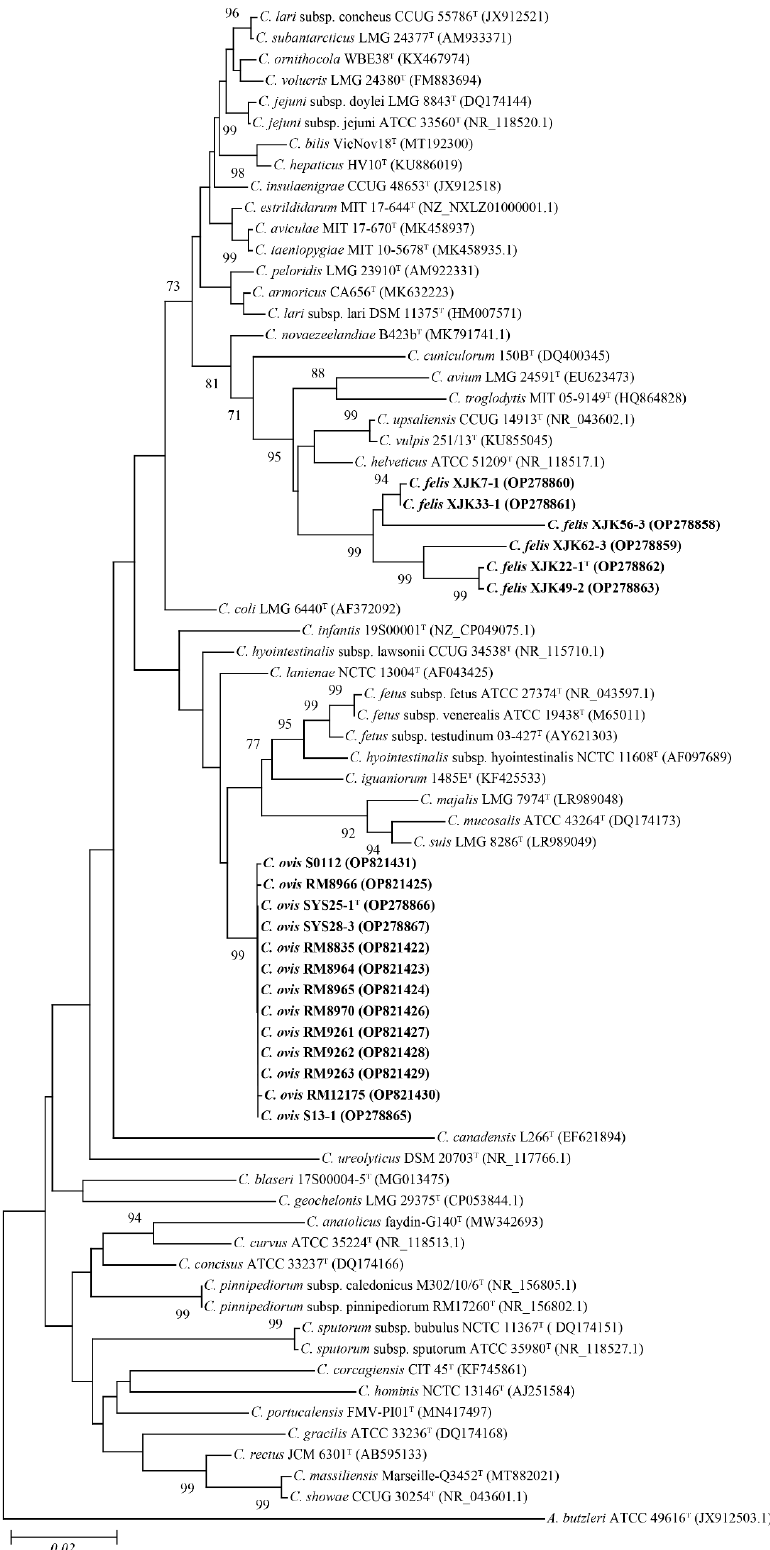
Figure 2. Neighbor ‐ joining phylogenetic tree based on nearly complete 16S rRNA gene showing the relationships between our isolates and the type strains of the genus Campylobacter . Bootstrap values (>70%) based on 1000 replicates are shown at branch nodes, with Arcobacter butzleri ATCC 49616 T as an outgroup. Bar—0.02 changes per nucleotide position. Novel strains are highlighted in bold.